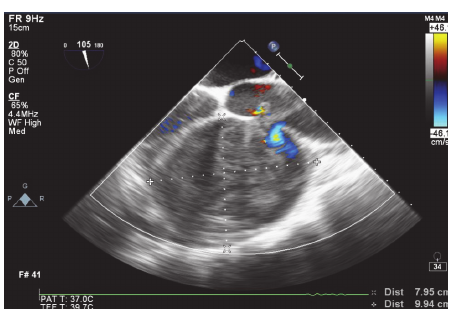
Figure1 Giant coronary sinus aneurysm Figure 1 Giant coronary sinus aneurysm